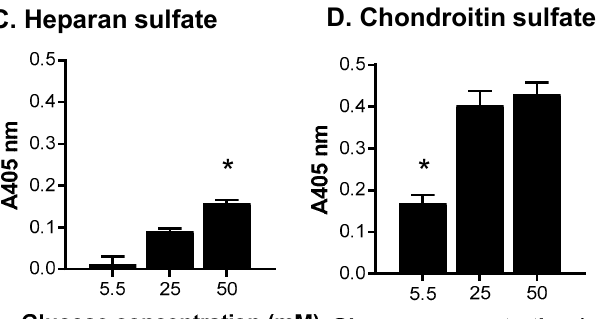
Figure 6. The effects of altering glucose concentrations in media for the production of serglycin, heparan sulfate/heparin and chondroitin sulfate. ELISA for the presence of ( A ) serglycin was detected using a polyclonal anti-serglycin antibody; ( B ) heparan sulfate/heparin stubs were detected using anti-heparan sulfate stub antibody clone 3G10 following HepIII digestion; ( C ) heparan sulfate chains were detected using anti-heparan sulfate antibody clone 10E4; and ( D ) chondroitin sulfate chains were detected using anti- chondroitin sulfate chain antibody clone CS-56. Data are presented as means ± standard deviation ( n = 3). * indicates significant differences ( p < 0.05) compared to 25 mM glucose analyzed by one-way ANOVA.